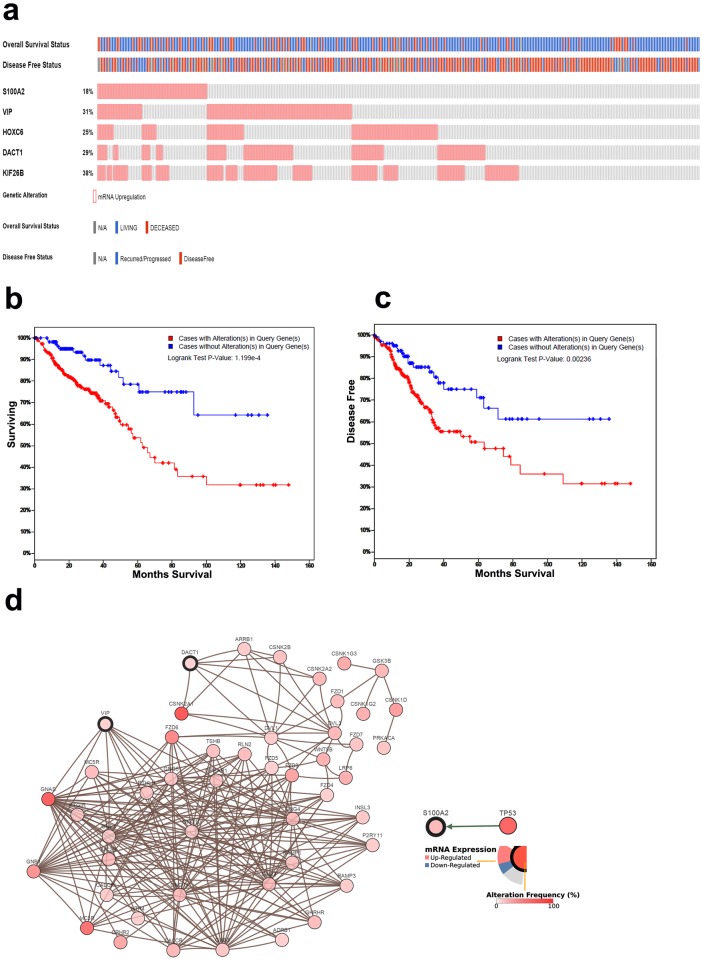
Validation of the distant recurrence (DR) gene panel in the TCGA dataset.(a) OncoPrint of the DR five-gene signature in the TCGA CRC dataset. Alteration in the expression of different members of the five-gene signature (rows) in relation to each sample (columns). Relationships to overall and disease-free survival are also shown. CRC cases with upregulated expression of the DR signature showed worse overall (b) and disease-free (c) survival than cases with lower expression. (d) Network view of the VIP/DACT1/S100A2 neighborhood in CRC. VIP, DACT1, and S100A2 are seed genes (indicated with thick borders), and all other genes were identified as altered in CRC.